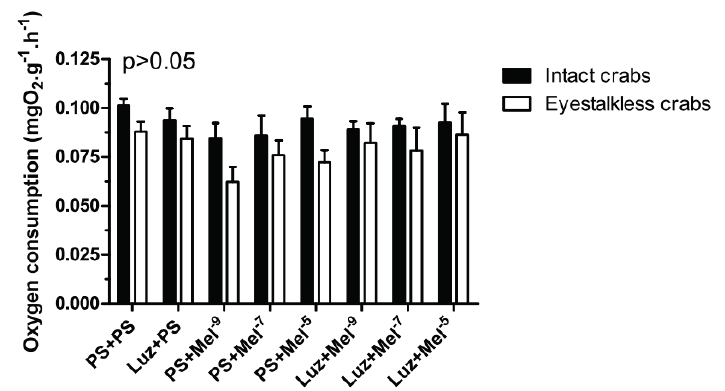
Figure 10. Oxygen consumption (VO 2 ) of intact (black bars) and eyestalkless (open bars) Neohelice granulata exposed for 45 min only to 6 mgO 2 ·L − 1 and injected with physiological saline only (CTR) luzindole (200 nmol·crab − 1 ) plus physiological saline, physiological saline plus melatonin (200 pmol·crab − 1 ), or luzindole (200 nmol·crab − 1 ) plus melatonin (200 pmol·crab − 1 ). Each point represents the mean ± SE ( n = 3–4). No significant differences ( p > 0.05) were